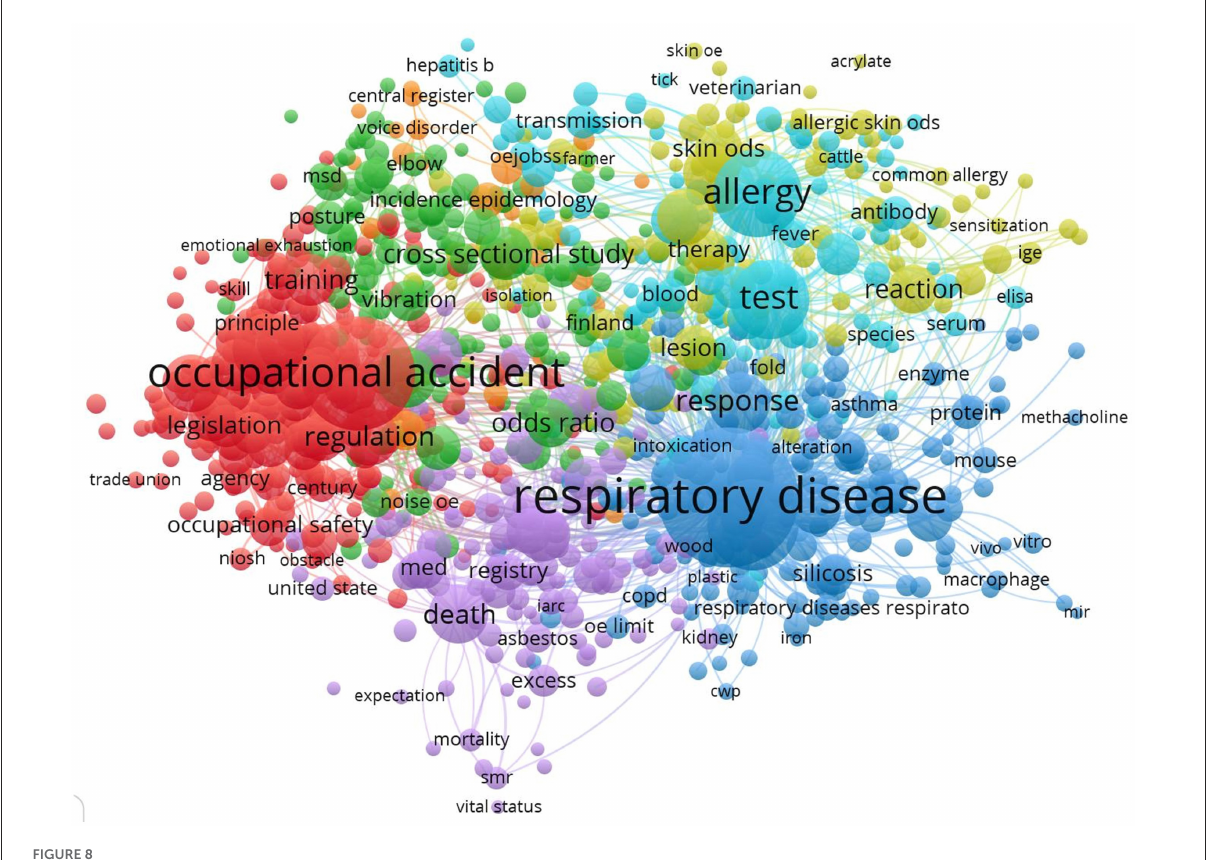
FIGURE8 Keyword communication